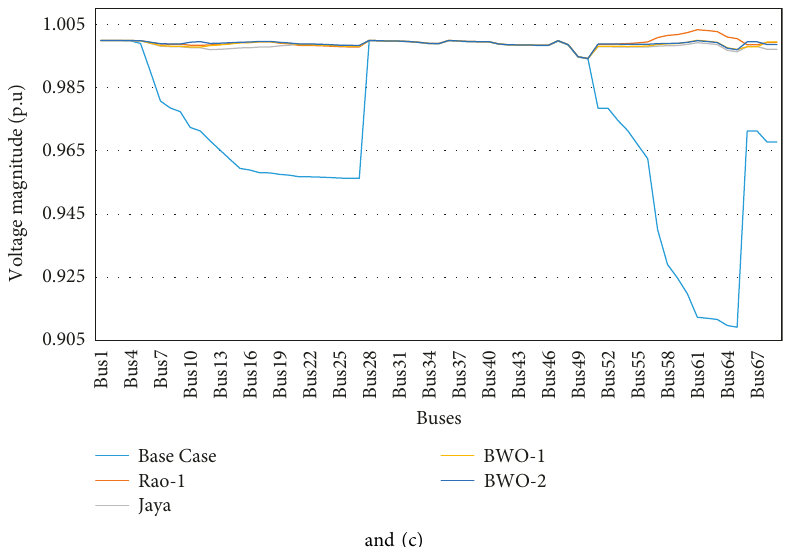
Figure 16: Comparison of bus voltages for the 69-bus test system with the simultaneous allocation of (a) 1DG and 1SC, (b) 2DGs and 2SCs, and (c) 3DGs and Table 9: Performance comparison of the BWO-2 against the established optimization techniques for the 69-bus test system. Cases